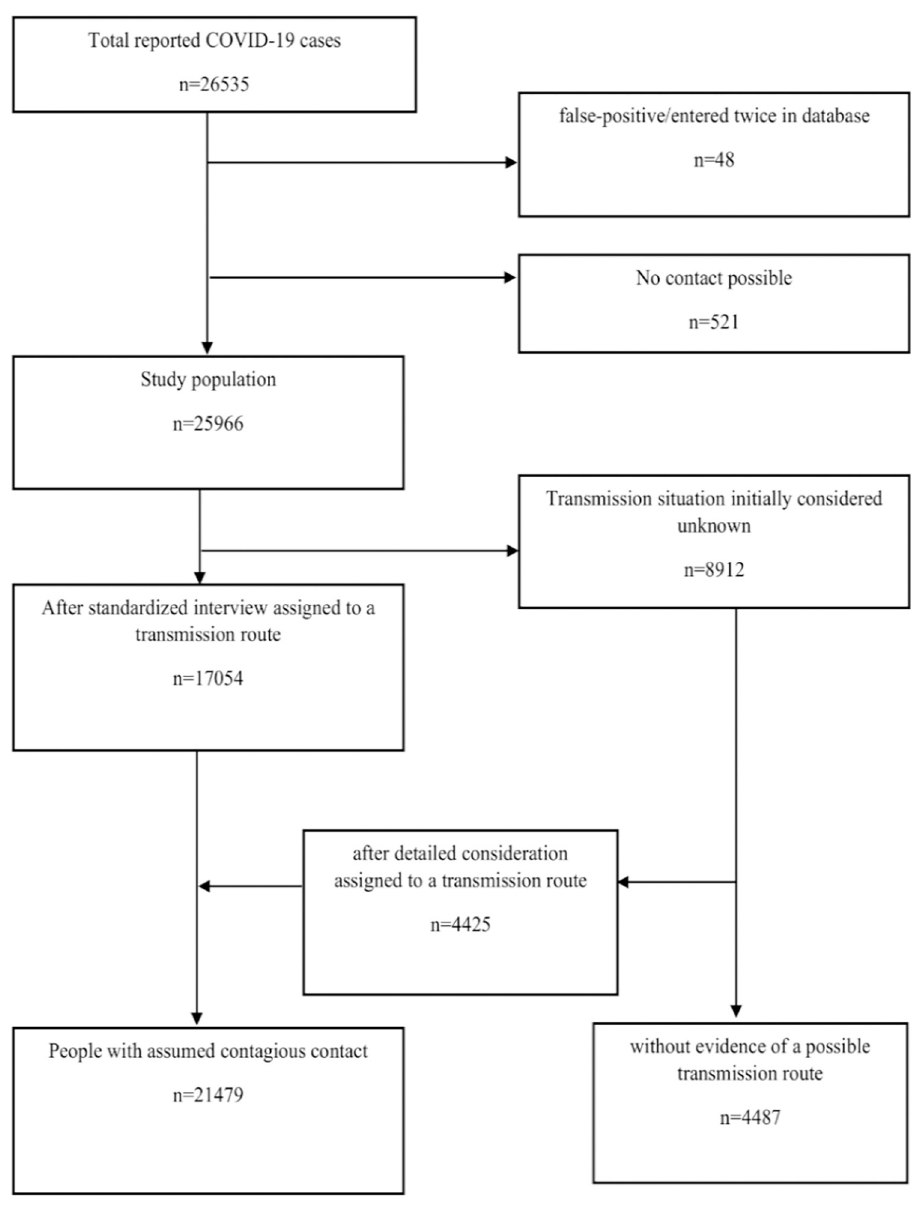
Fig 2. Flow chart: Study